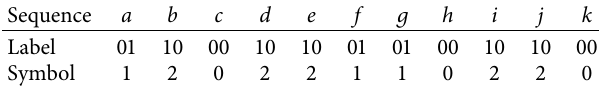
Table 3: Symbolized results of